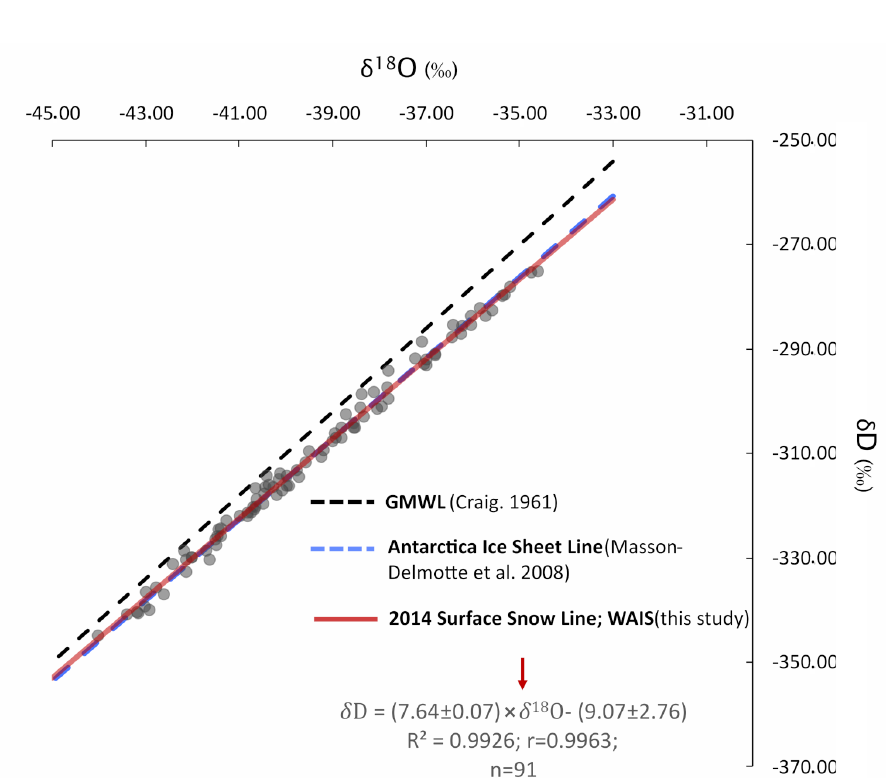
Figure 3. Variability of the d -excess as a function of the distance from the coast (direction is marked on the map by the red arrow) along the 2015 BR-WAIS traverse route. On the left of the graph, the results for N-S transect (2) (purple dots) and E-W transect (3) (pink dots) results. On the right, the results for N-S transect (1) (green dots).